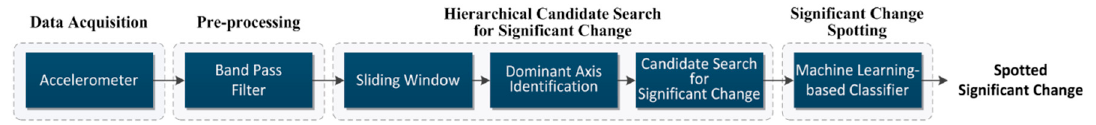
Figure 1. The architecture of the proposed approach for the segmentation mechanism, including data acquisition, pre-processing, hierarchical candidate search for significant change, and significant change spotting.